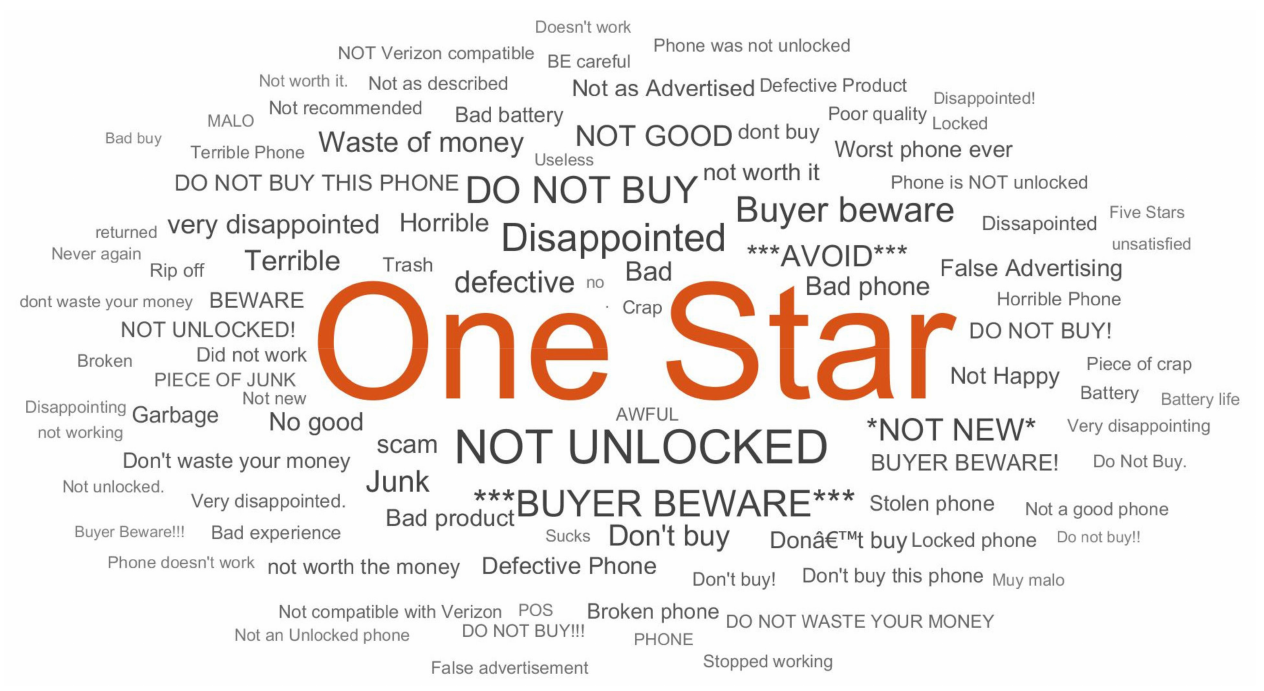
Figure 14. Word-cloud plot analysis for words with review score one.